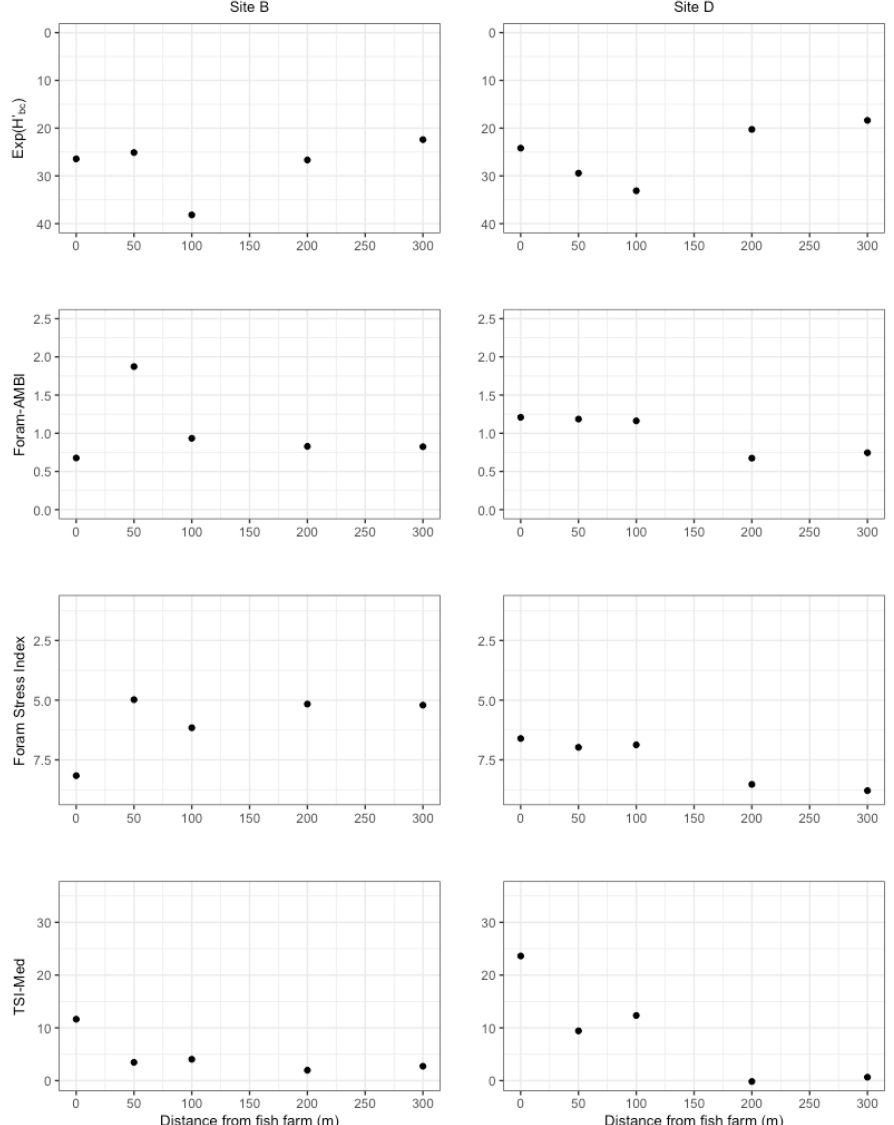
Figure 9. Plots of biotic indices exp(H’ bc ), Foram-AMBI, Foram Stress Index and TSI-Med along the transect at both sites. Decreasing values (Foram-AMBI and TSI-Med) or increasing values (exp (H’ bc ) and FSI) indicate improving ecological conditions.